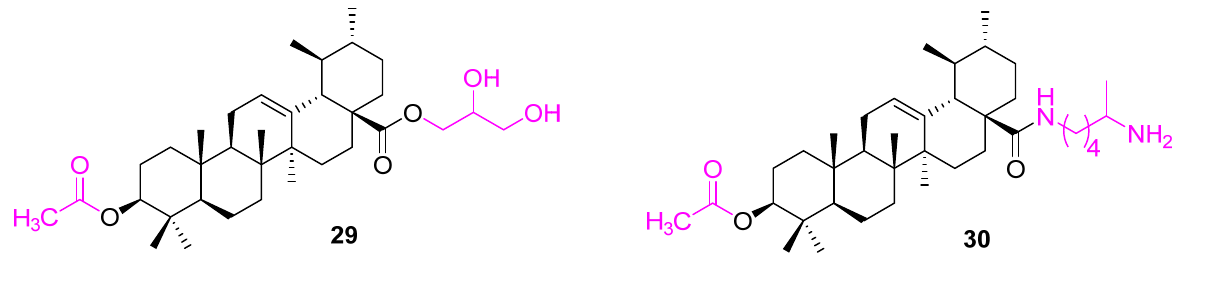
Figure 19. Structure of 29 , 30 .